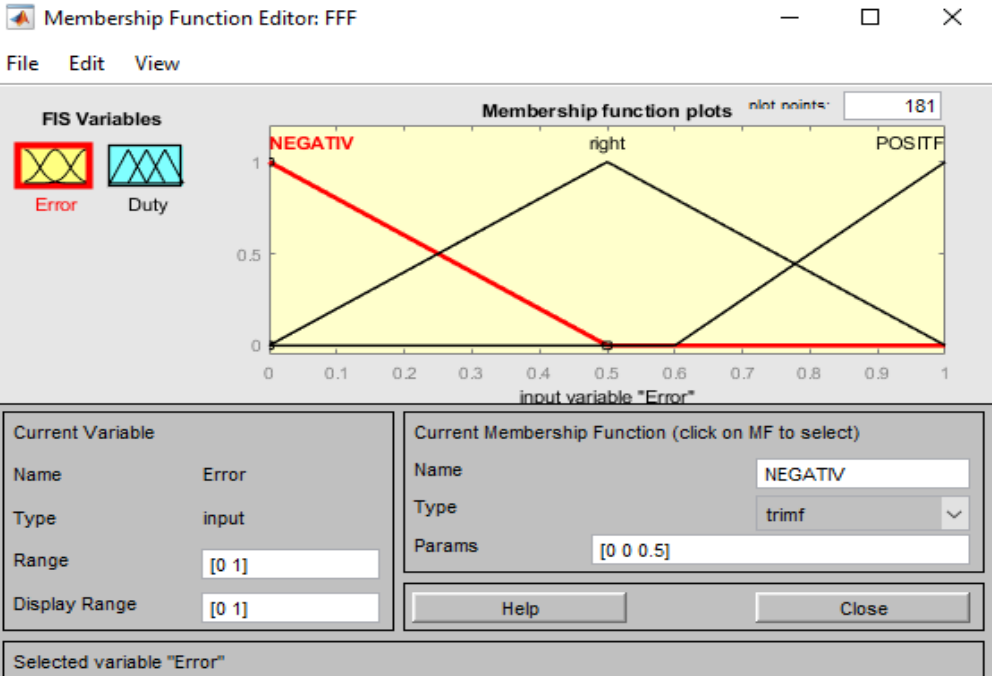
Figure 11. Block diagram of the fuzzy control system.